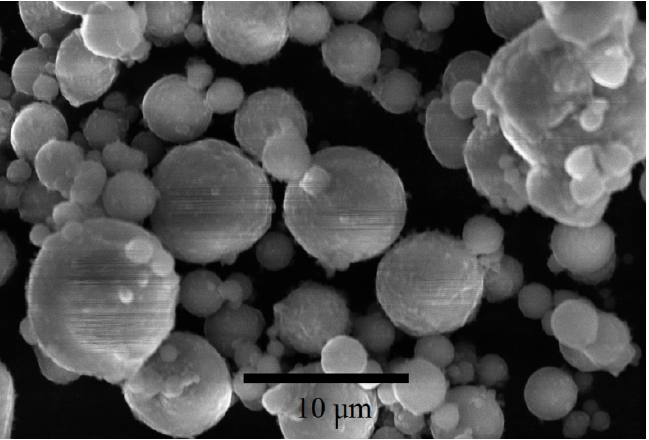
Figure 2. SEM-image of aluminum micropowder ASD-4.